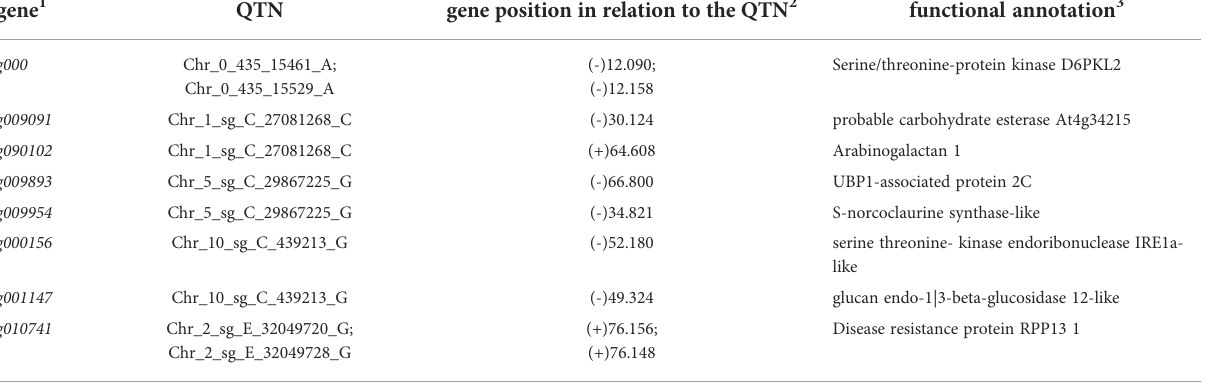
TABLE 2 Functional annotation of genes near to QTNs associated with resistance to BHB in C. arabica identi fi ed in this study. gene 1 QTN gene position in relation to the QTN